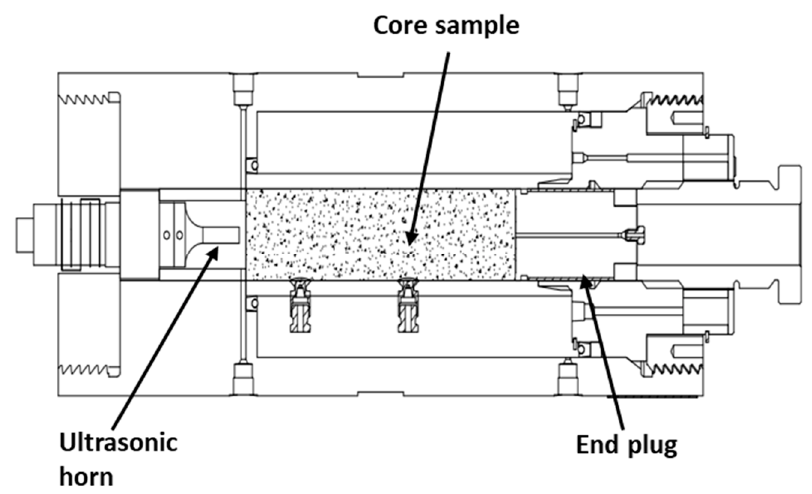
Figure 10. Hassler-type core holder with ultrasound (designed for the authors by DCI Test